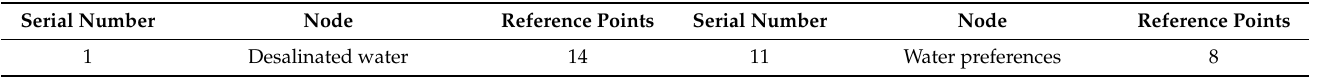
Table 9. Summary of automatically coded topic nodes and reference points from